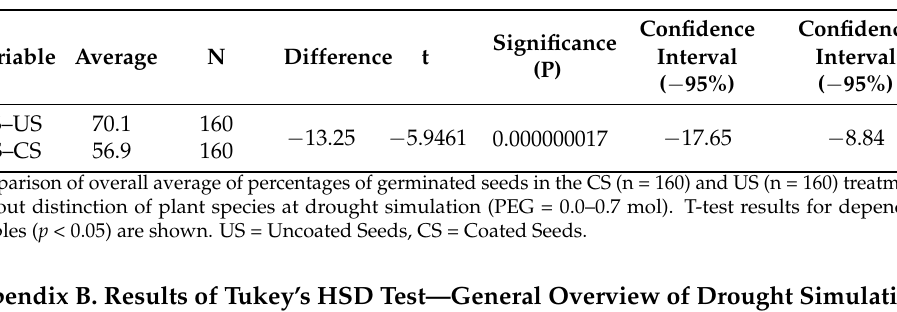
Confidence Confidence Significance Interval Interval ( − 95%)